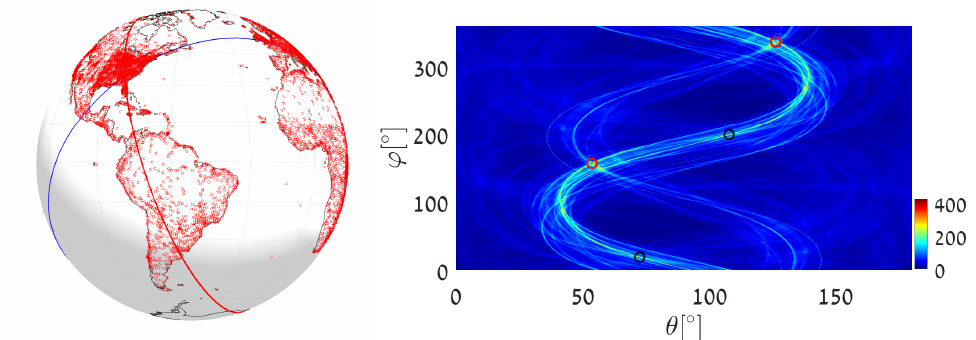
Figure 21. Executing Algorithm 3 on the city database. ( Left ) The blue great circle passes through the maximum number of cities (red dots). The red circle corresponds to the second maximum, following the unvoting process. ( Right ) Heat plot of the accumulator array M , showing the parameters of the two great